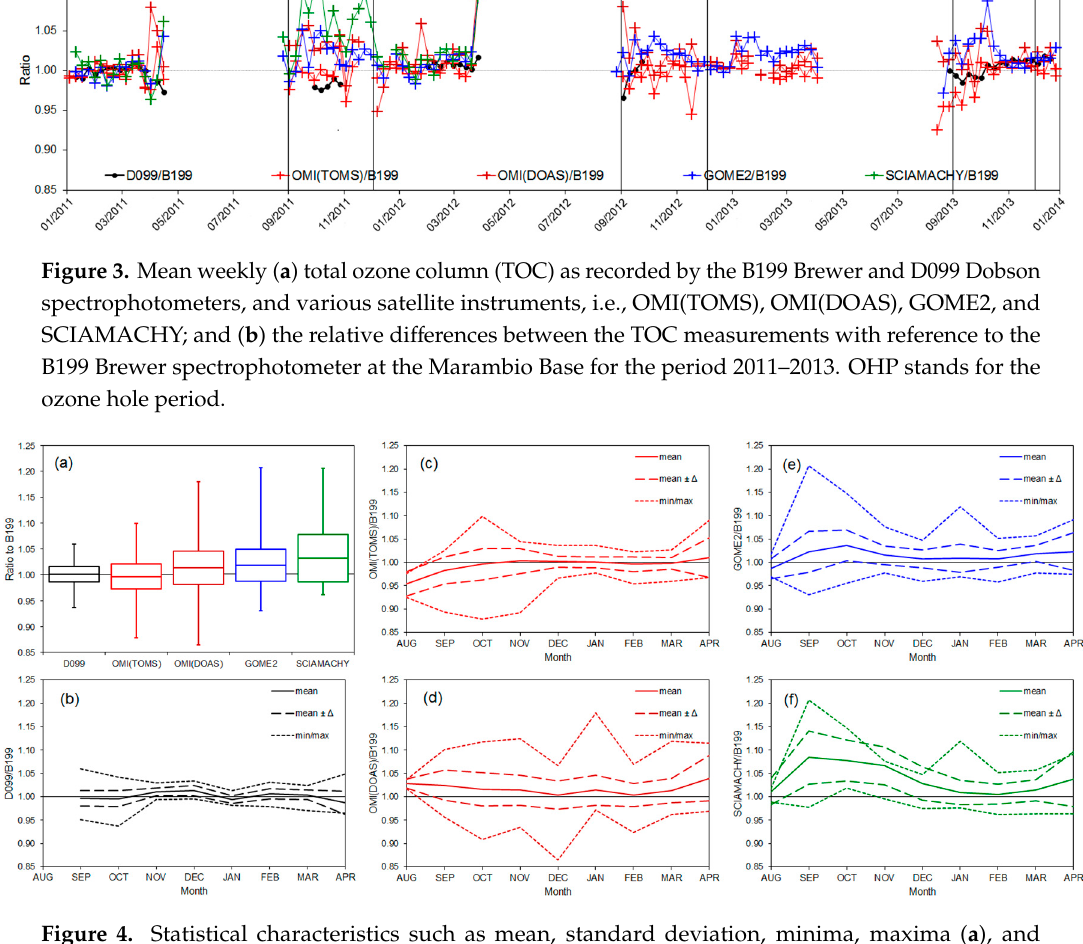
Figure 4. Statistical characteristics such as mean, standard deviation, minima, maxima ( a ), and mean monthly changes in the ratios in relation to the B199 ozone column for ( b ) the D099, ( c ) the OMI(TOMS), ( d ) the OMI(DOAS), ( e ) the GOME2, and ( f ) the SCIAMACHY at the Marambio Base for the period 2011–2013.